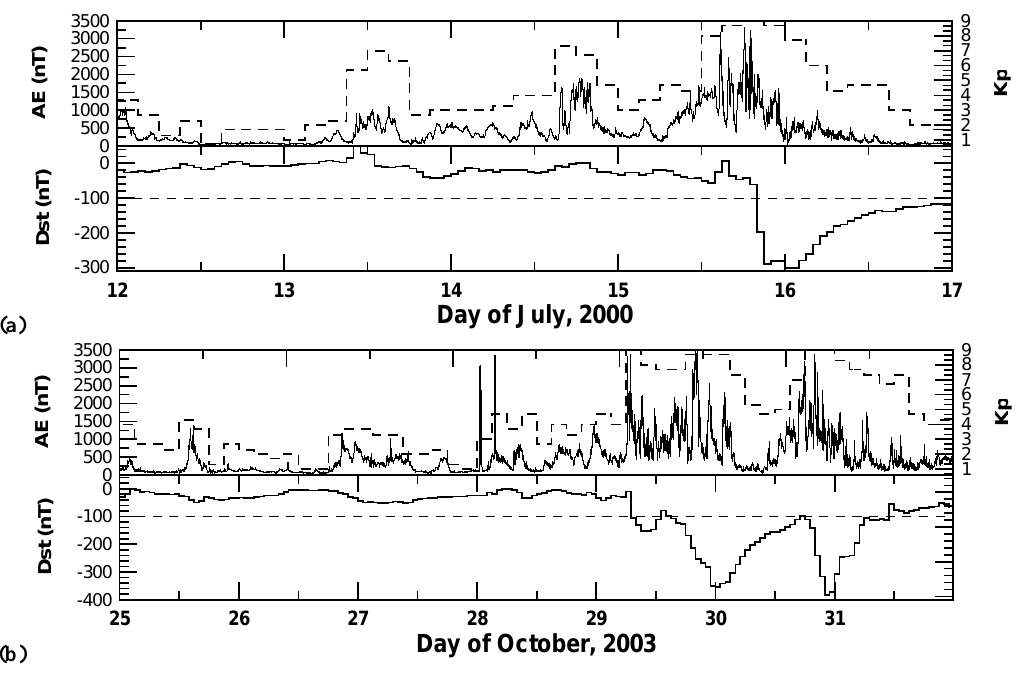
Fig. 1. Geomagnetic activity before and during (a) Bastille storm and (b) Halloween storms. Auroral AE index (solid curve, left axis) and mid-latitude K p index (dashed histogram, right axis) are presented at upper panels. Storm-time D st -variation is shown at lower